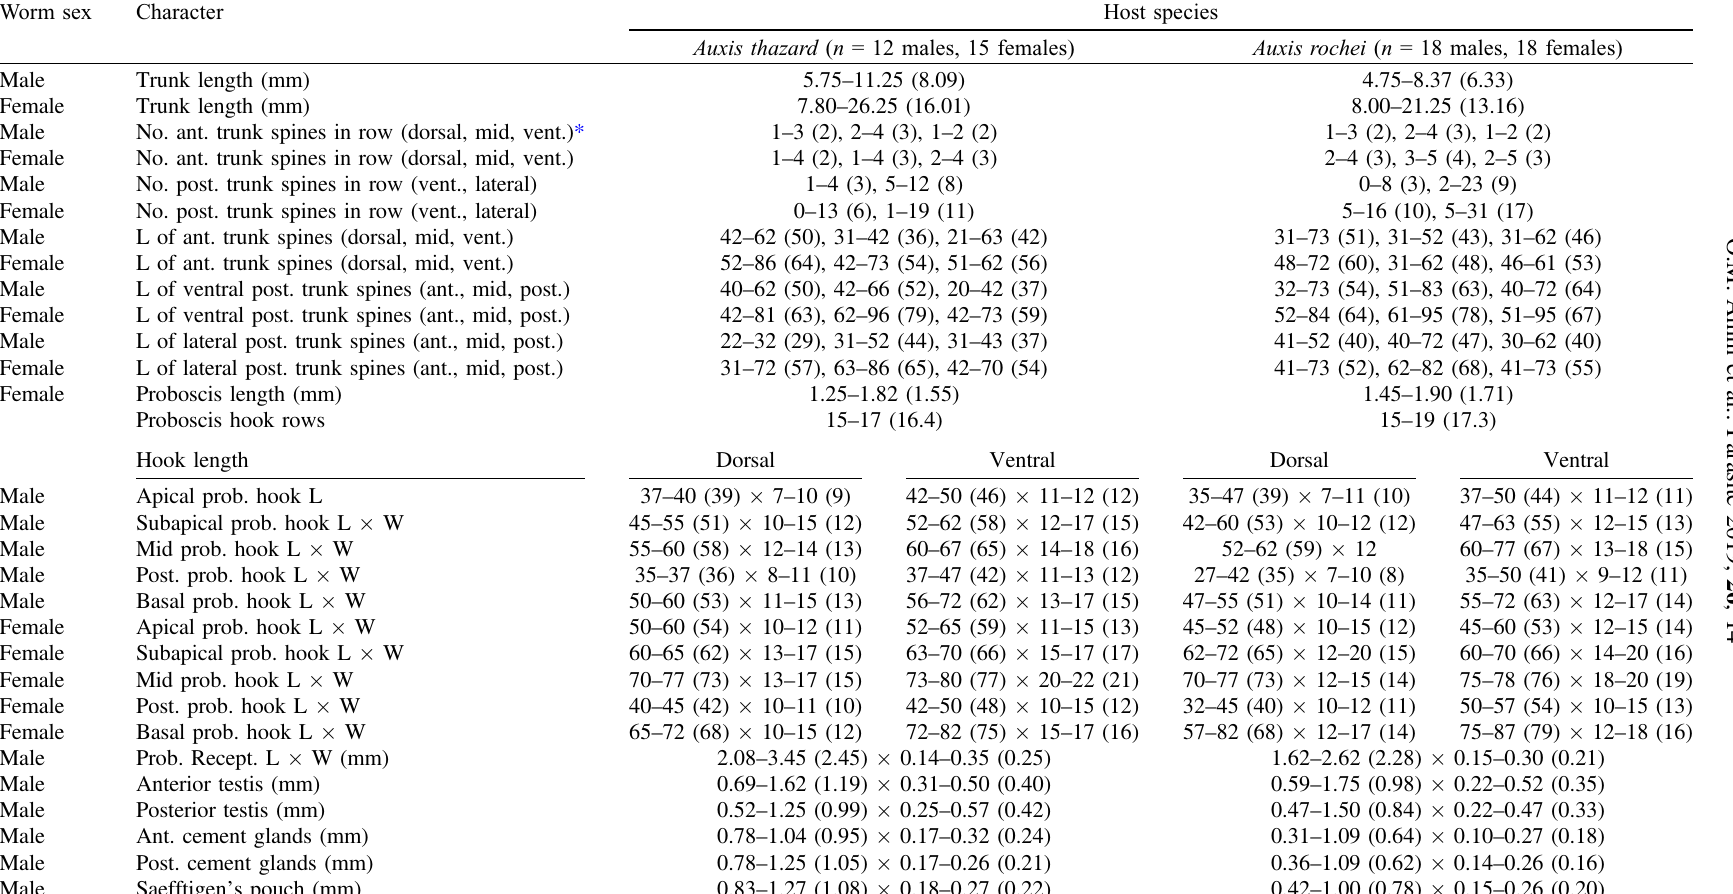
Table 2. The relationship between host species and size of certain anatomical structures of measured specimens of Rhadinorhynchus laterospinosus collected off the Paci fi c coast of Vietnam in